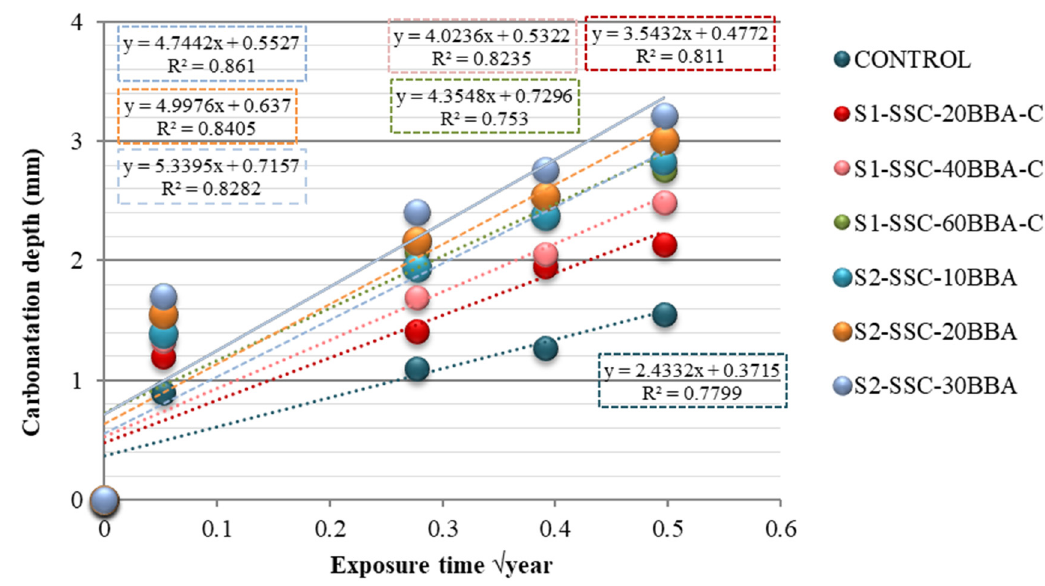
Figure 8. Relationship between carbonatation depth and exposure time.